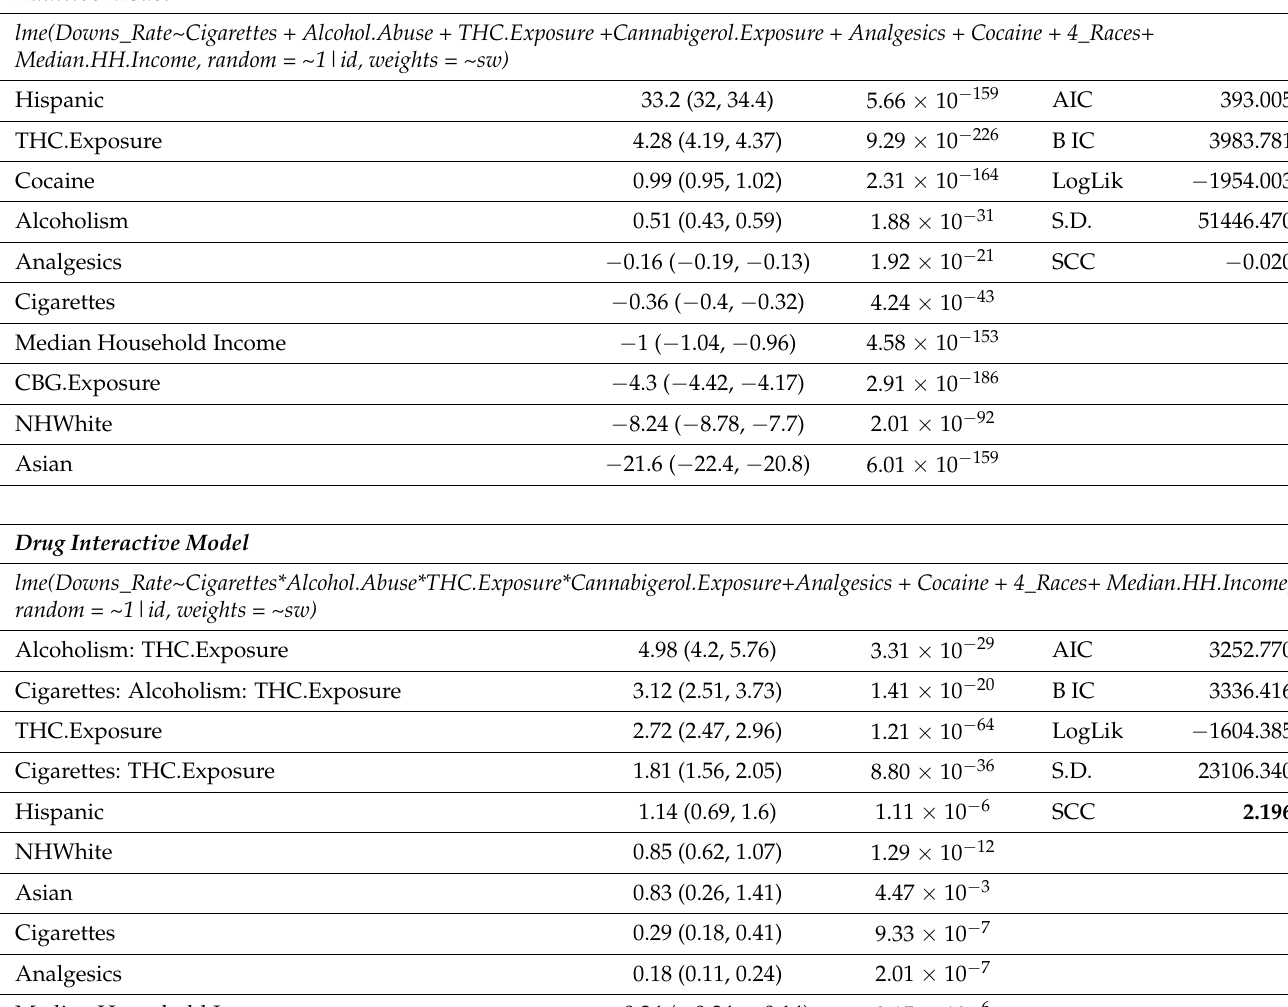
Table 3. Mixed Effects Model with Inverse Probability Weights—Fixed Effects. Standardized Covariates. Parameter Model Covariate Estimate (C.I.) p -Value